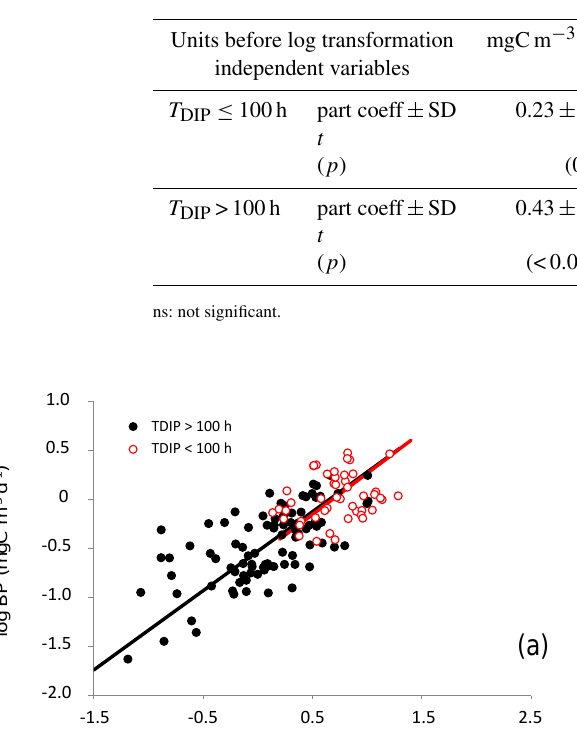
Table 3. Results of multiple regressions log BP = f (log PP, log N 2 fix). The BP unit before log transformation is ng CL − 1 h − 1 . Y int is the intercept with the Y axis. Partial coefficient of regression (part coeff), t value ( t ) and probability of the regression to be significant ( p ).